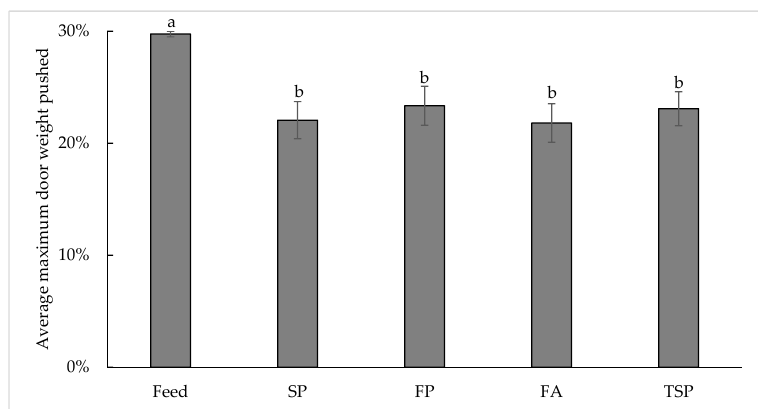
Figure 4. The average maximum weight pushed (0%, 10%, 20%, or 30% of chicks’ median pen body weight) to access resources in the treatment compartment (feed, soiled pine and spruce wood shavings (SP), fresh pine and spruce wood shavings (FP), fresh aspen wood shavings (FA), ammonia reductant treated soiled pine and spruce wood shavings (TSP)). Bars with different letters display significant differences ( p < 0.05).